Question: Draft a figure caption describing what is shown.
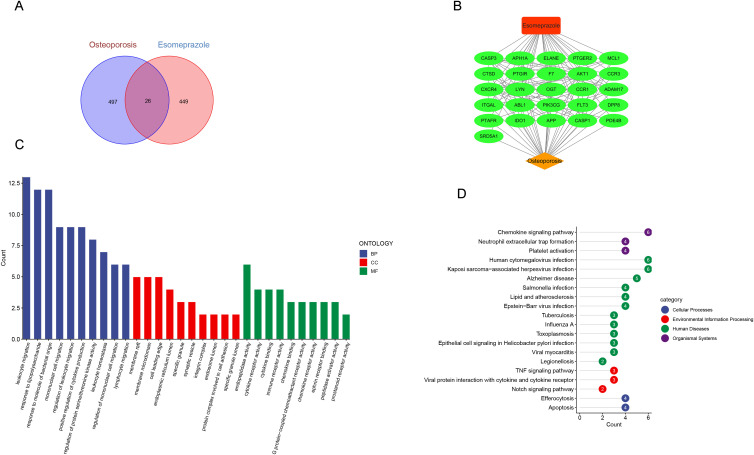
Answer: Identification of common targets and enrichment analysis between esomeprazole and osteoporosis. (A) Venn diagram showing the overlapping genes between predicted targets of esomeprazole and DEGs associated with OP. (B) Network visualization of shared targets between esomeprazole and OP. Green circles represent genes, the orange quadrilateral represents OP, and red-bordered nodes indicate esomeprazole. (C) GO enrichment analysis of the 26 shared genes. The bar chart displays the number of genes enriched in each term across three categories: BP, CC, and MF. (D) KEGG pathway enrichment analysis of shared genes. The lollipop chart indicates the number of enriched genes in each pathway, with different colors representing distinct KEGG categories.